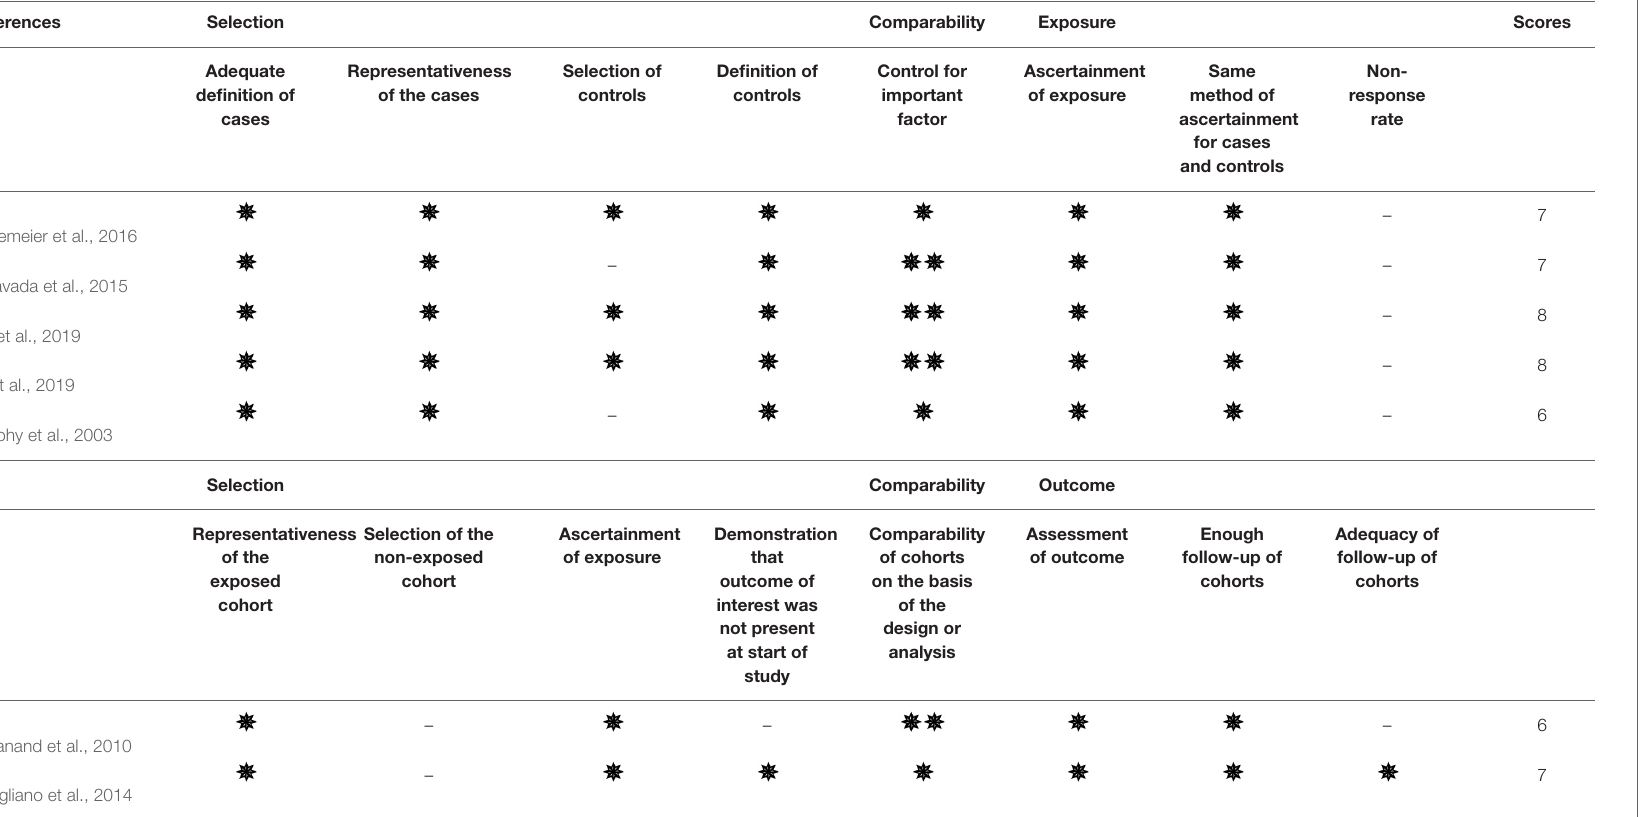
TABLE 2 | The Newcastle-Ottawa scale